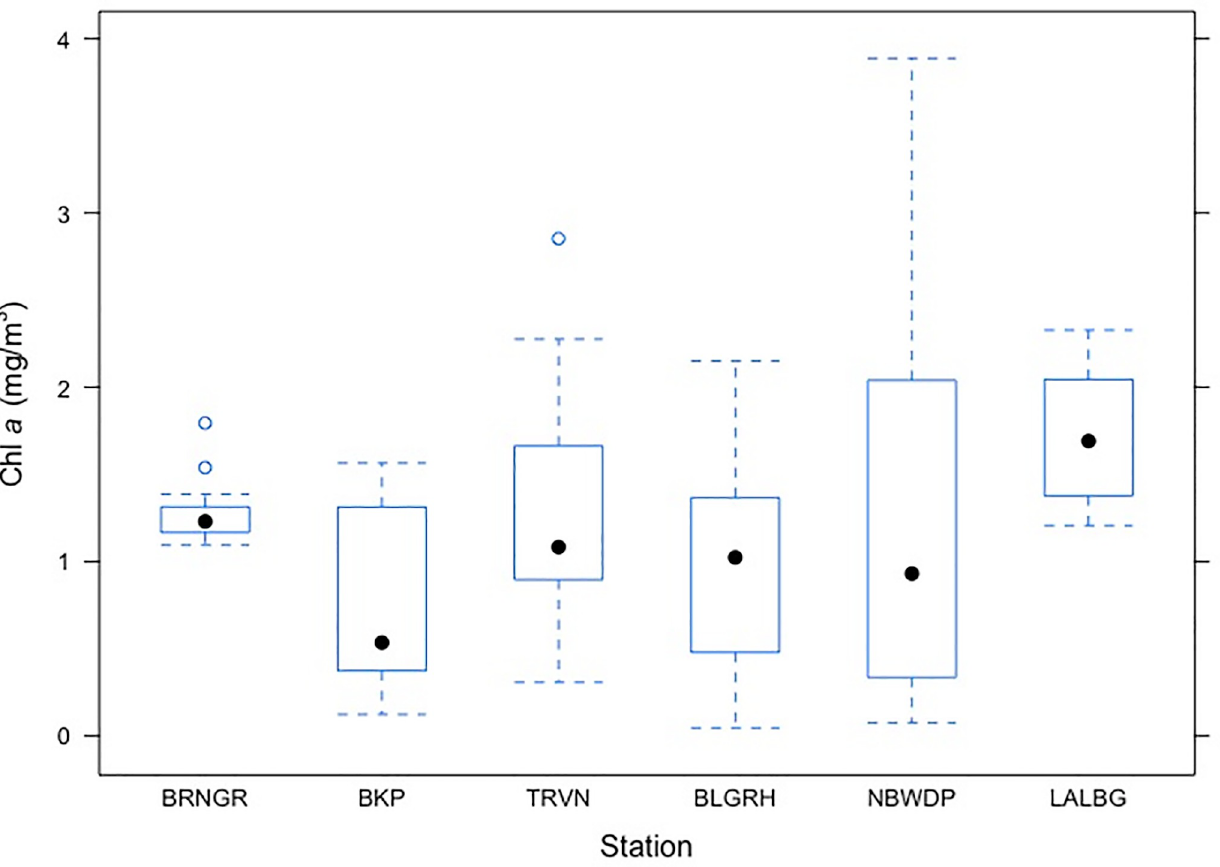
Fig 8. Box plot depicting Chlorophyll a concentration at different stations. X axis depicts sampling stations of Chl a data collection along Bhagirathi Hooghly river stretch; Sampling locations are abbreviated as follows—BRNGR: Baranagar; BKP: Barrackpore; TRVN: Triveni; BLGRH: Balagarh; NBDWP: Nabadweep; LALBG: Lalbag; Y axis denotes Chl a biomass (mg/m 3 ) at respective